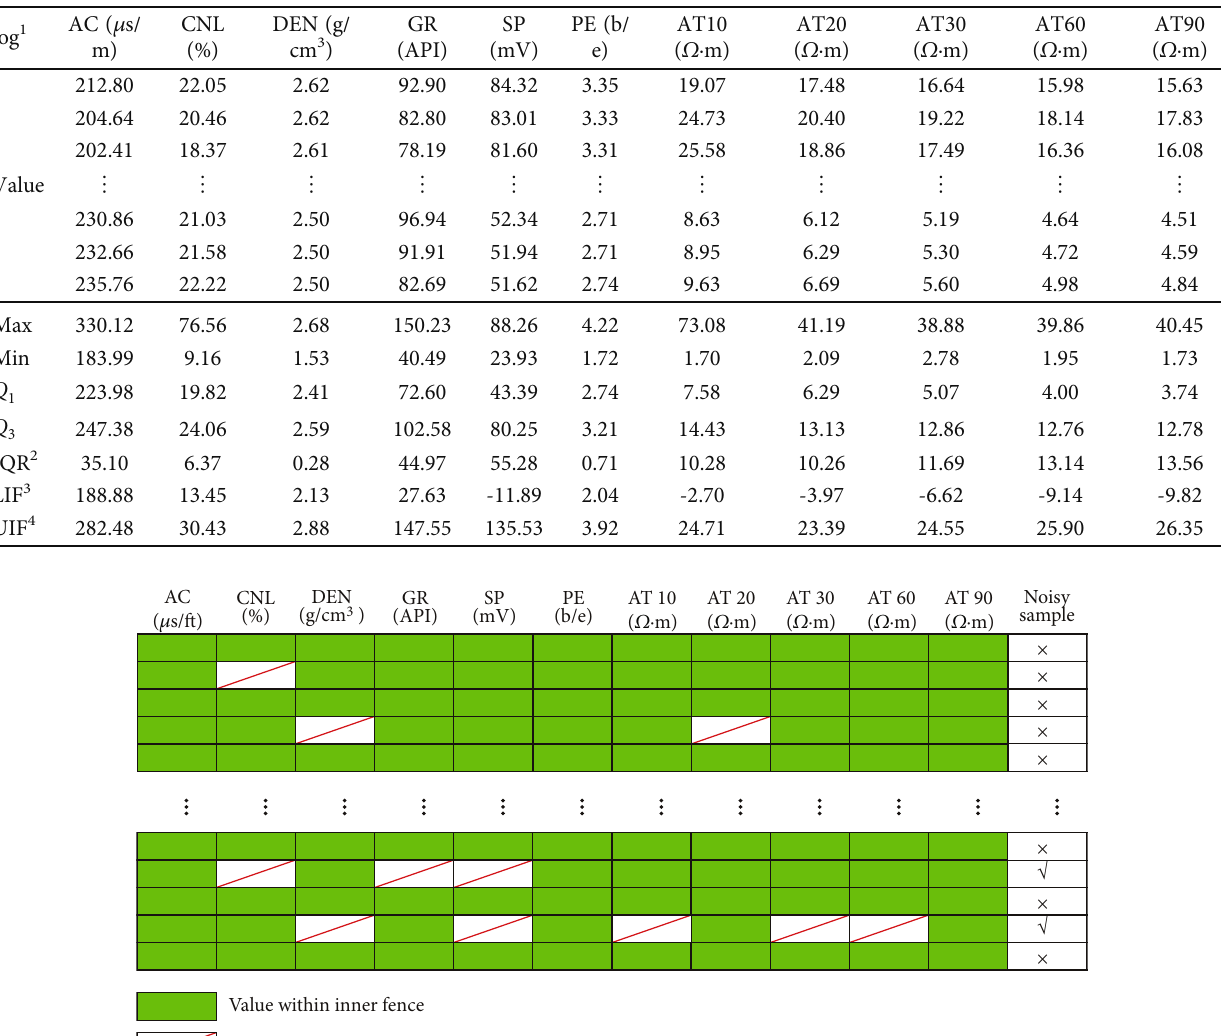
Table 2: Summary of quartile-based statistical information of applied well logs.